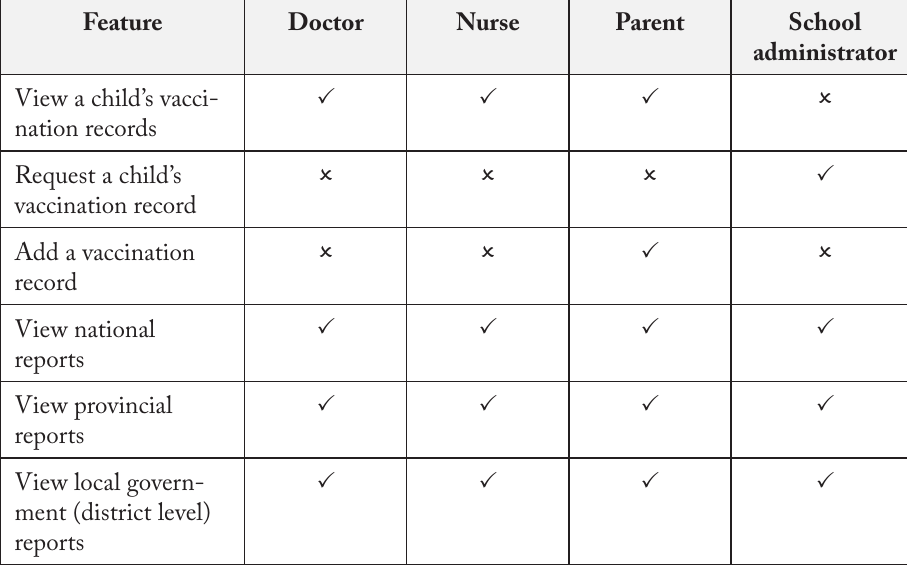
Table 4: Features included in e-Vaccination, per stakeholder type